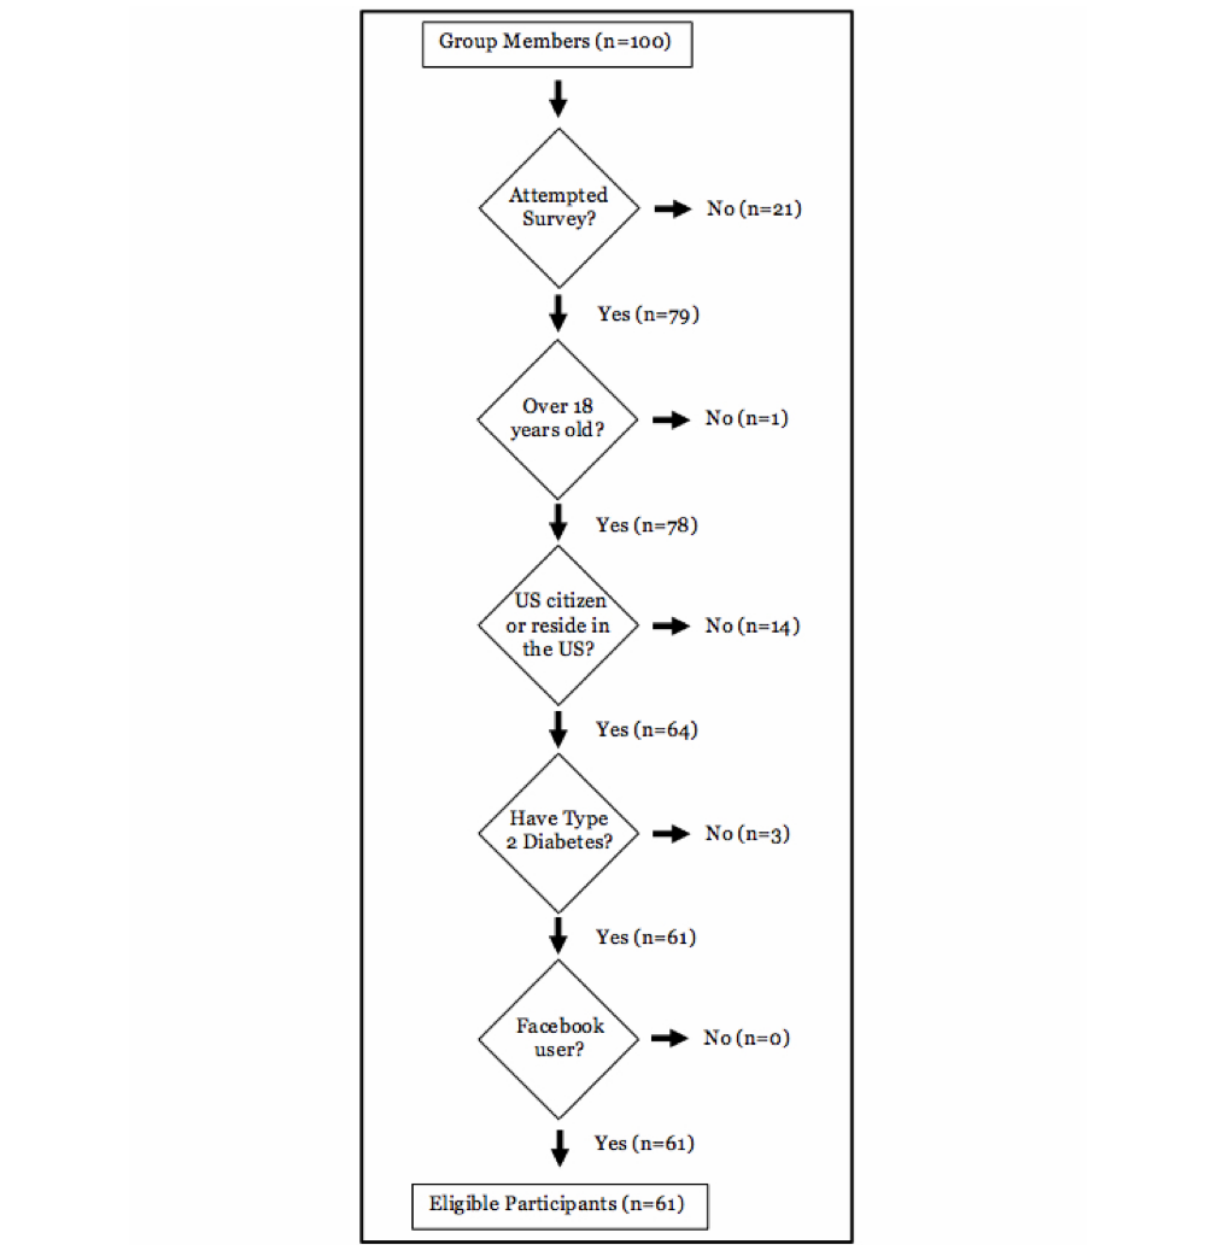
Figure 7. Reasons for Study 2